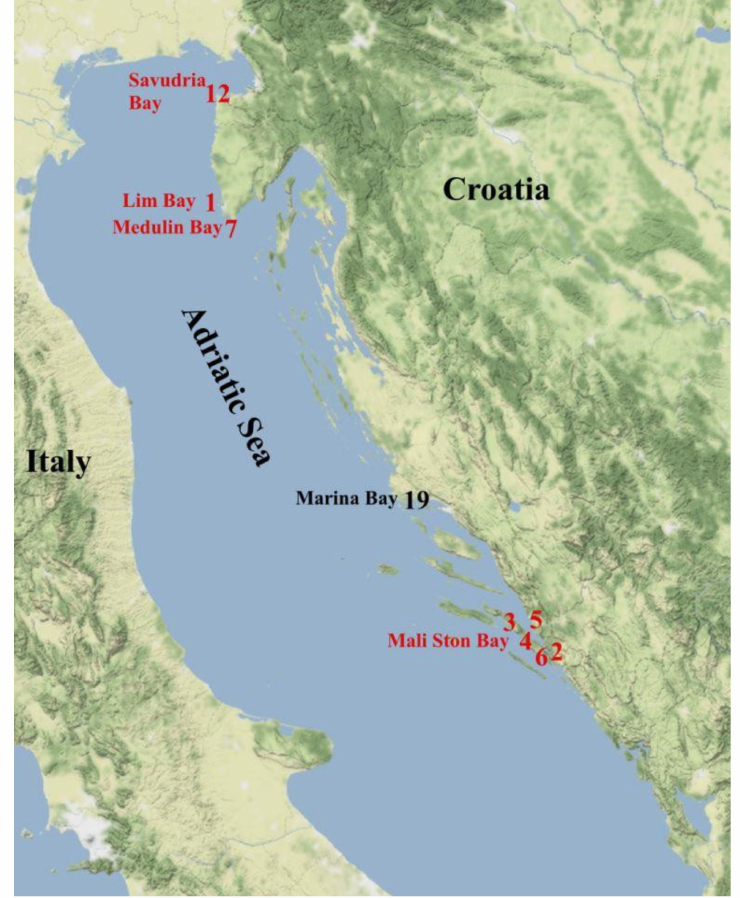
Figure 1. Map showing European flat oyster ( O. edulis ) production areas with sampling points included in the national surveillance plan. A production area in the south with five sampling points and three production areas in the north Croatian Adriatic Sea tested positive (red numbers) for B. exitiosa in 2016–2020. The numbers refer to production areas/sampling sites listed in Table